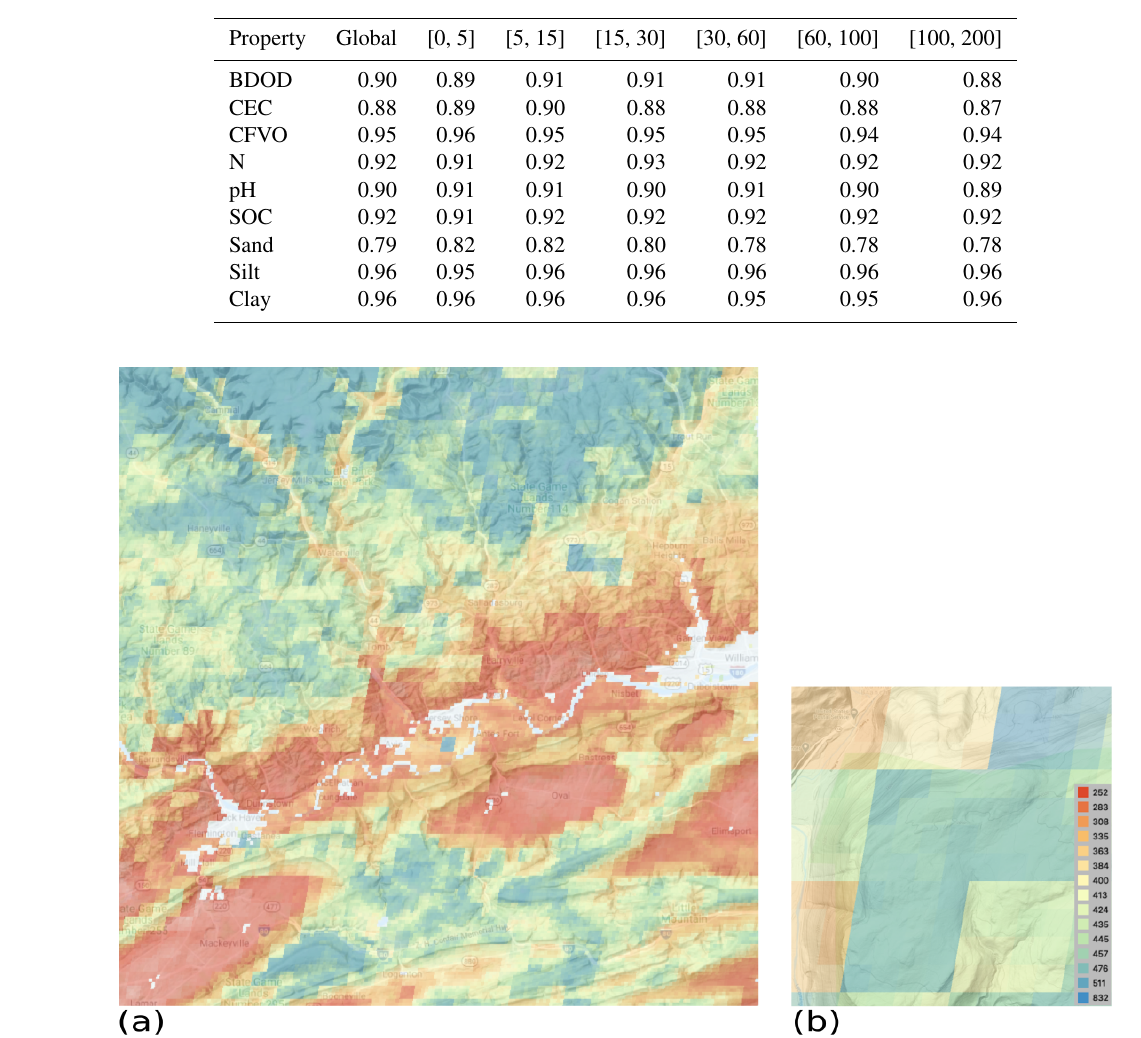
Figure 6. Predicted sand concentration, %, 0–5cm, ground overlay in © Google Earth. (a) Overview; centre ≈ − 77 ◦ 14 (cid:48) E, 41 ◦ 14 (cid:48) N, near Jersey Shore, PA. (b) Detail; centre ≈ − 76 ◦ 56 (cid:48) E, 41 ◦ 33 (cid:48)